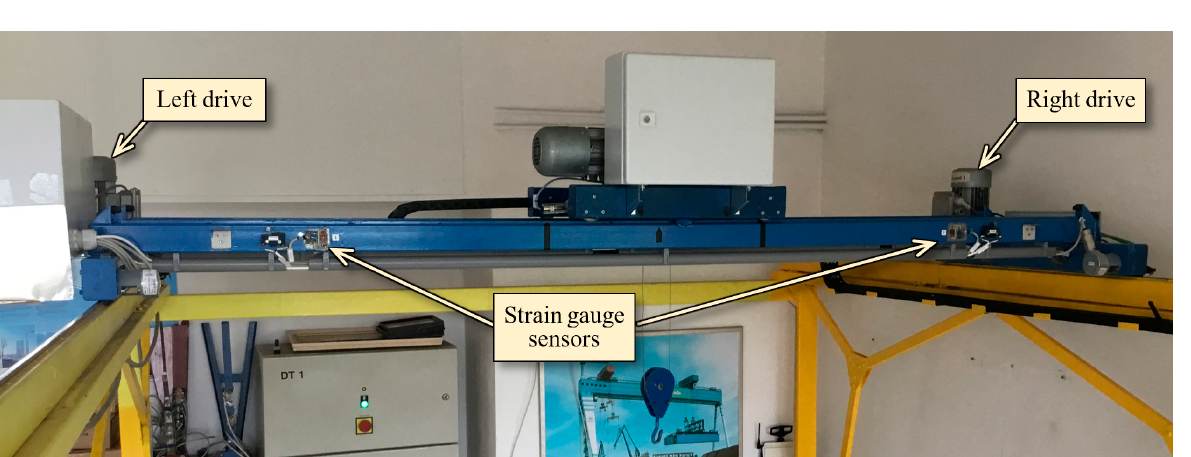
Figure 8. Application of the strain gauge sensors on the given bridge crane. Transformation of the resistance changes from the strain gauge sensors to the output signal was performed by the EMS170 converters from the EMSYST company. These converters supply the sensors with stabilized voltage and also with direct current, and they amplify the output signal. The block diagram of the EMS170 converter is displayed in Figure 9.